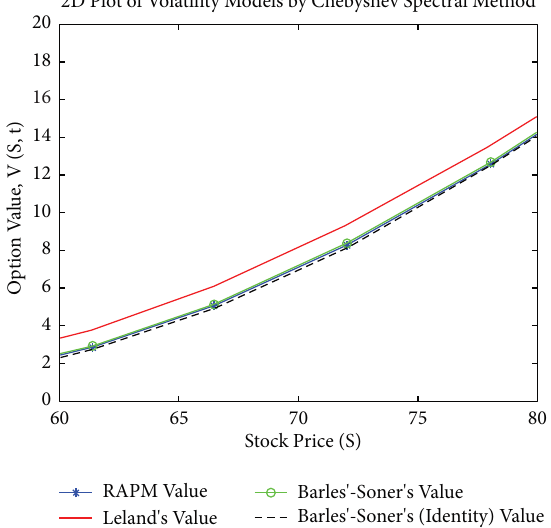
Figure 7: 2D plot of volatility models by Chebyshev spectral method at t � 0.